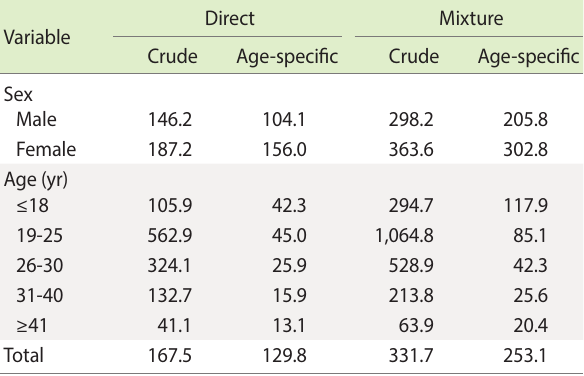
Table 4. The crude and age-adjusted rates 1 of attempted suicide by deliberate self-poisoning in 2015